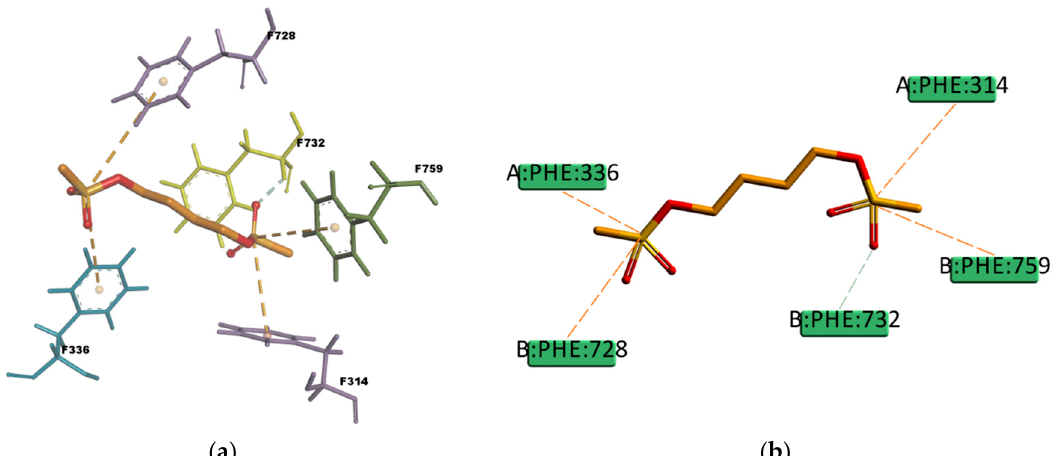
Figure 22. Busulfan (BU) top-ranked pose obtained with CDOCKER algorithm. ( a ) 3D view of BU interactions in the binding pocket. The light-green dotted line represents a carbon hydrogen bond interaction, and the orange dotted lines represent π –sulphur interactions. Residue F732 involved in a carbon hydrogen bond interaction is highlighted in yellow; ( b ) 2D interaction diagram of BU with h P-gp interacting residues. The light-green dotted line represents a carbon hydrogen bond interaction, and the orange dotted lines represent π –sulphur interactions with residues F336, F728, F314, and F759.